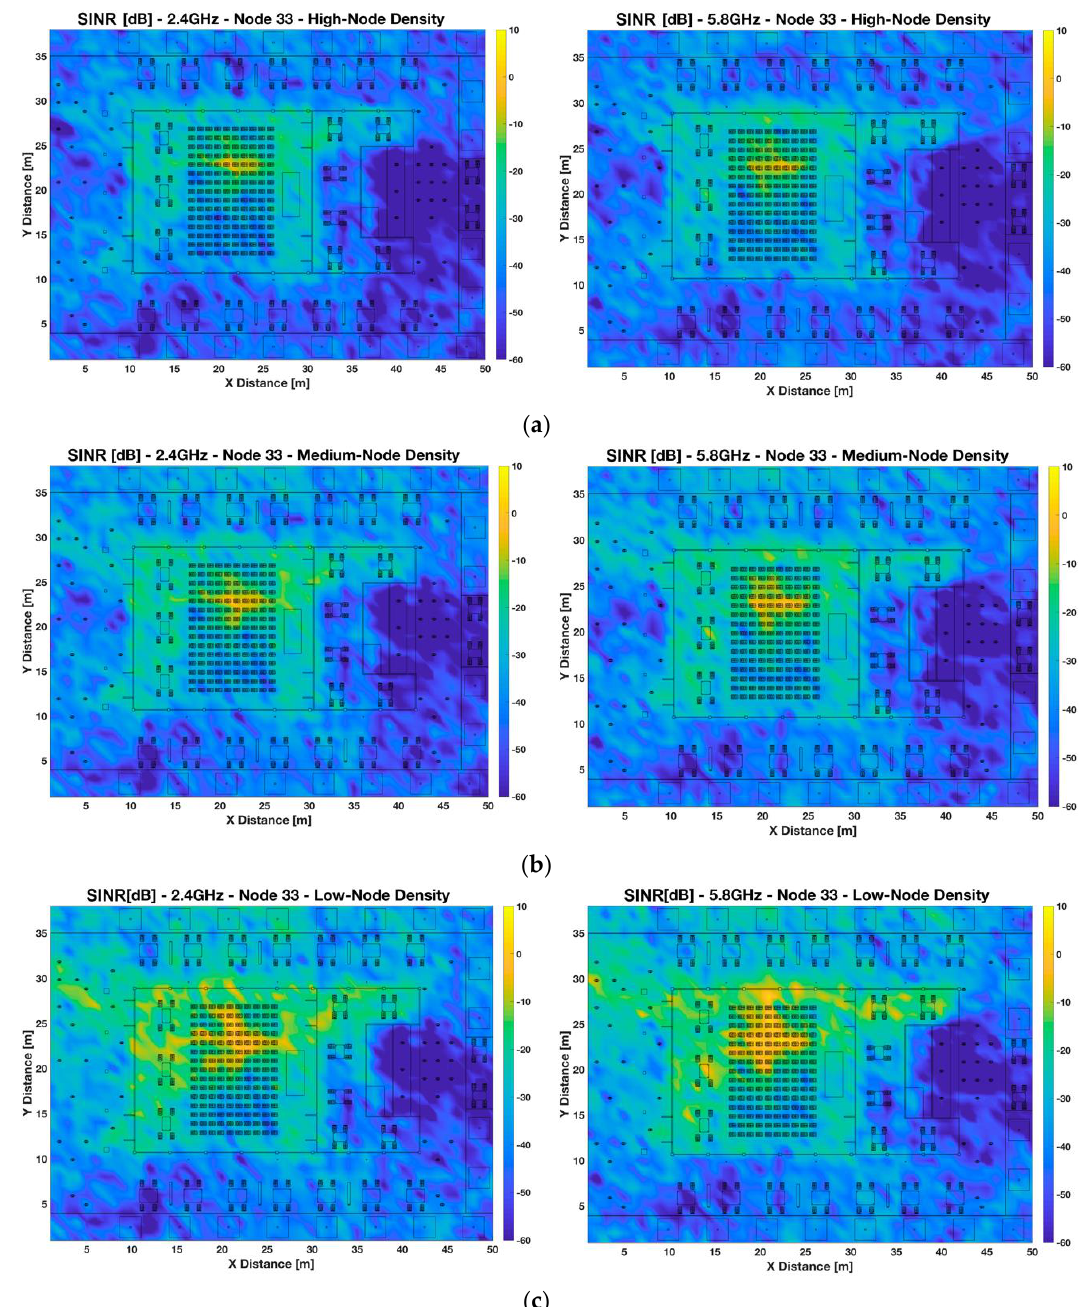
Figure 6. Bi-dimensional planes of signal to interference noise ratio (SINR) [dB] for Node 33 (wearable placed at 1.2 m height, same as a seated person in the indoor area of the auditorium, X = 20.35 m, Y = 22 m) at 2.4 GHz and 5.8 GHz frequency bands. Different scenario setups have been considered: ( a ) high-node density scenario, ( b ) medium-node density scenario, and ( c ) low-node density scenario.